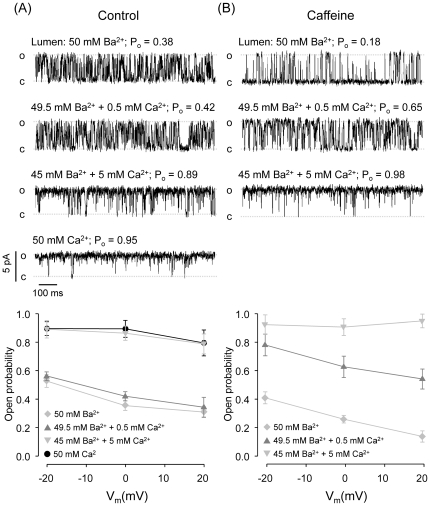
Effect of increasing luminal Ca2+ on the activity RyR2 bathed with luminal Ba2+
. (A) Single-channel recordings of a Ca2+-activated RyR2 ([Ca2+]cyt = 4 µM) exposed to the indicated luminal M2+ mixtures (Vm = 0 mV). The bottom panel summarizes the open probabilities obtained at three different holding voltages. Notice that the channels display maximal activation and no voltage-sensitivity when luminal Ca2+ is higher than 5 mM. (B) Single-channel recordings of a caffeine-activated RyR2 ([Caffeine] = 20 mM; Ca2+ = 100 nM) exposed to the indicated luminal M2+ mixtures (Vm = 0 mV). As shown in the bottom panel, a small increase in luminal Ca2+ (0.5 mM) was enough to induce a significant increase in Po. Further increase in luminal Ca2+ (5 mM) caused maximal activation and removed voltage-sensitivity.